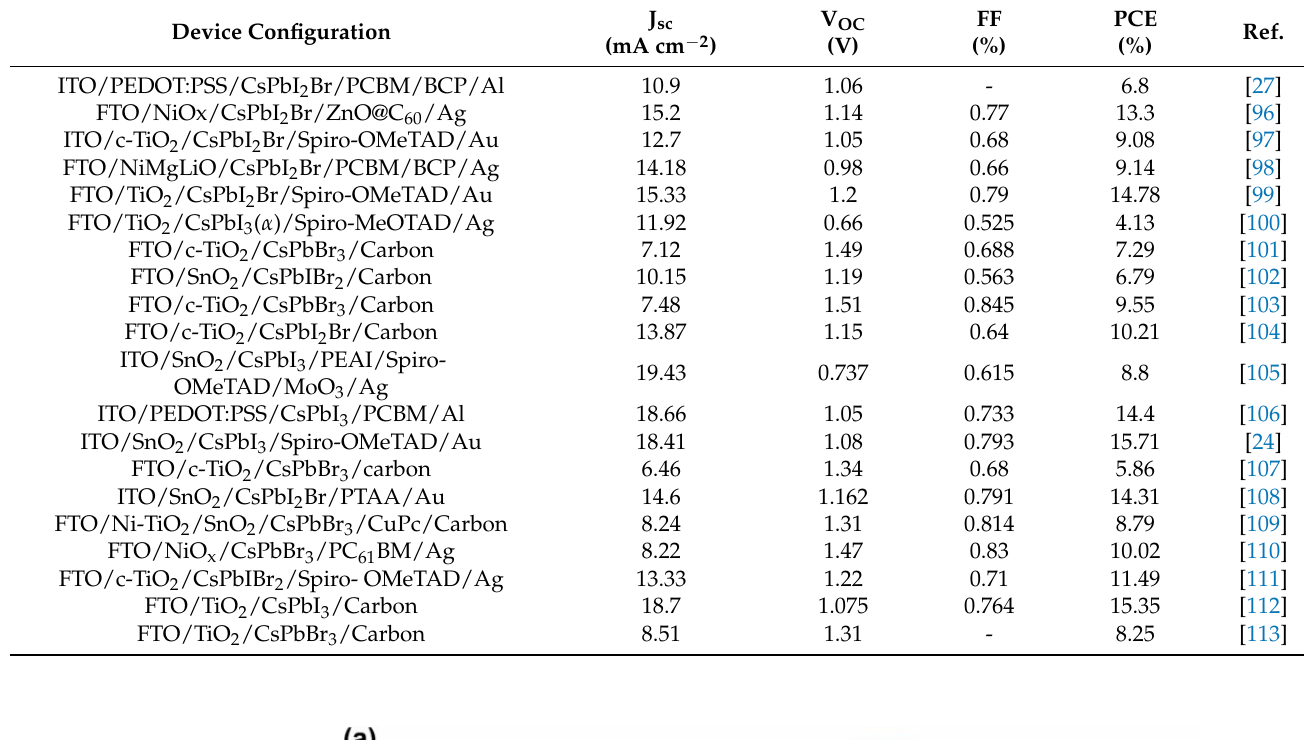
Table 2. Summary of various inorganic PSCs’ performance using solvent engineering.